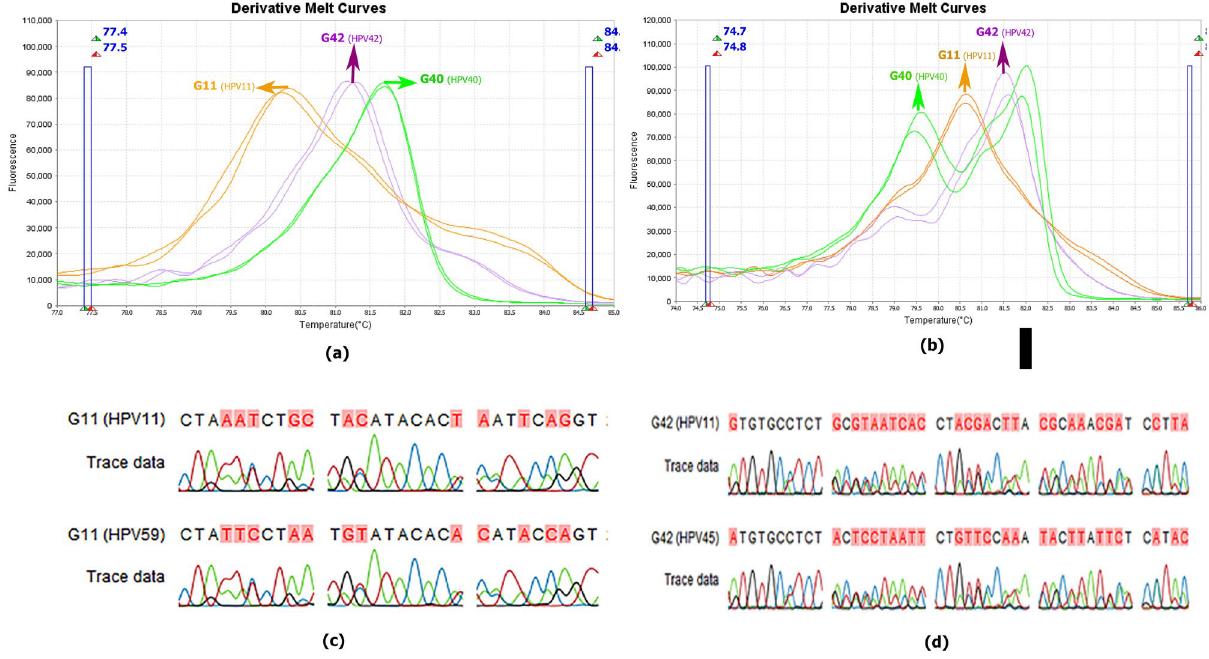
Figure 7. The derivative melt curve released of approach one is related to human papillomaviruses of isolates G11, G42, and G40 ( a ). The derivative melt curve released from approach two is related to isolates G11, G42, and G40 ( b ). Schematic map of the sequencing result of amplification region G11 and the presence of HPV mix infection after editing the sequence using CLC workbench 12 software ( c ). Schematic map of the sequencing result of amplification region G42 and existence of HPV mix infection after editing the sequence using CLC workbench 12 software ( d ).